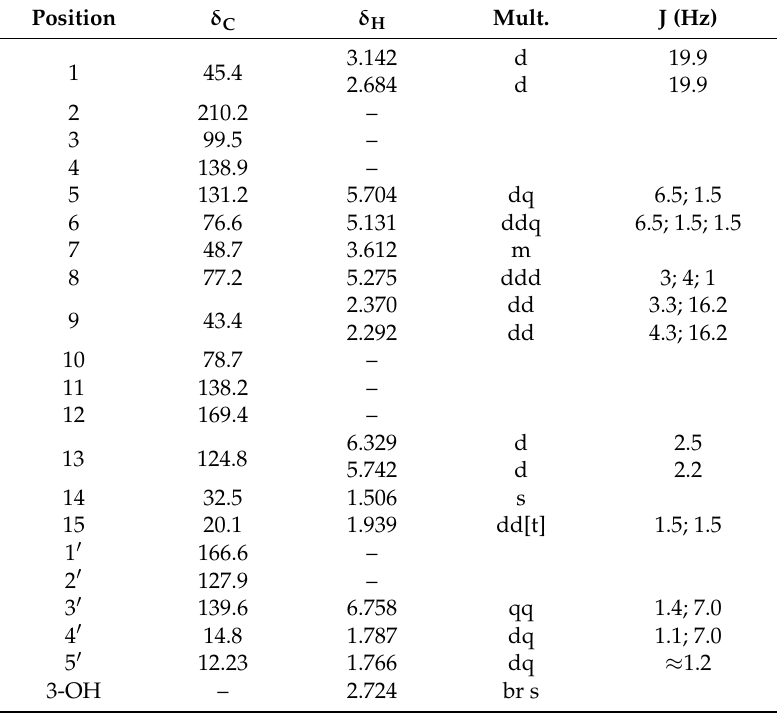
Figure 2. XP diagram representing the crystal structure of the new STL 4. Thermal ellipsoids are shown at 30% probability. Table 1. 13 C and 1 H NMR data of the new STL (sesquiterpene lactones) 4 (150 and 600 MHz, respectively, CDCl 3 ); all assignments were confirmed by 2D homo- and heteronuclear correlation spectra. δ C δ H